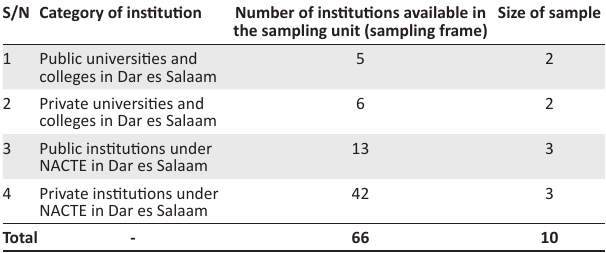
TABLE 1: Higher learning institutions in Dar es Salaam and